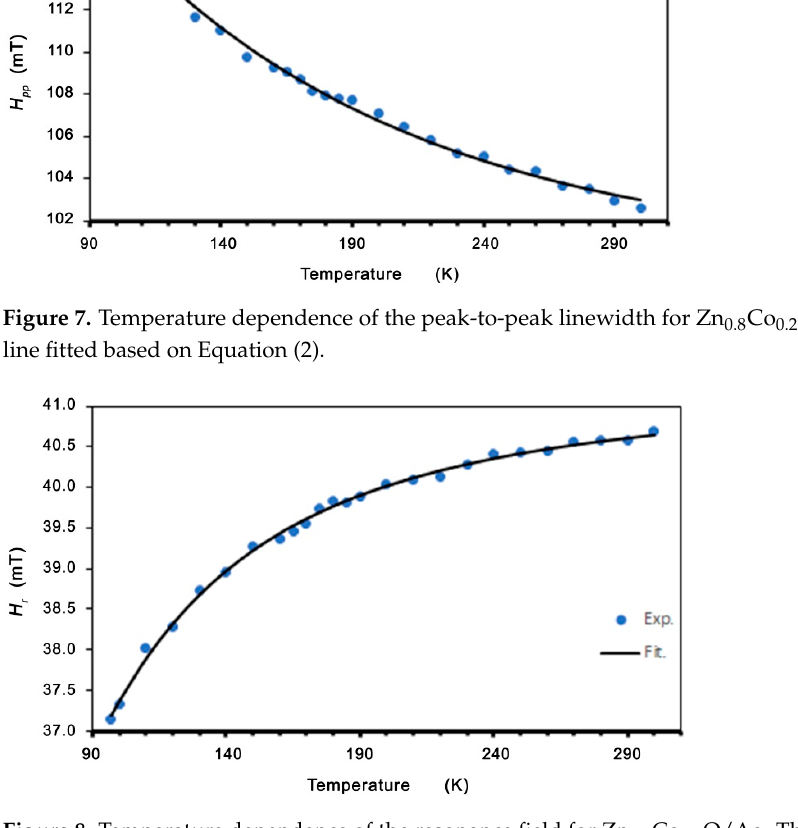
Figure 9. EMR spectrum recorded for an increasing (red) and decreasing (blue) magnetic field at 300 K for Zn 0.8 Co 0.2 O/Ag on a quartz substrate. A similar hysteresis of the LFMA line was observed for Zn 0.8 Co 0.2 O/Ag on a silicon substrate, shown in Figure 10.